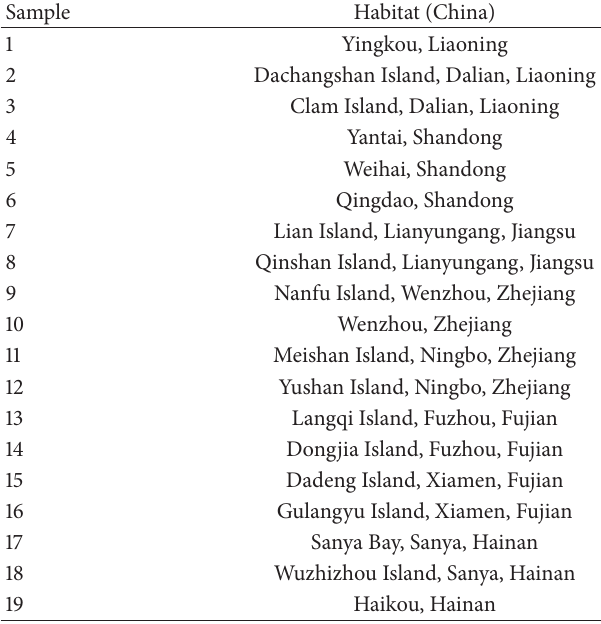
Table 1: Samples of Thais clavigera